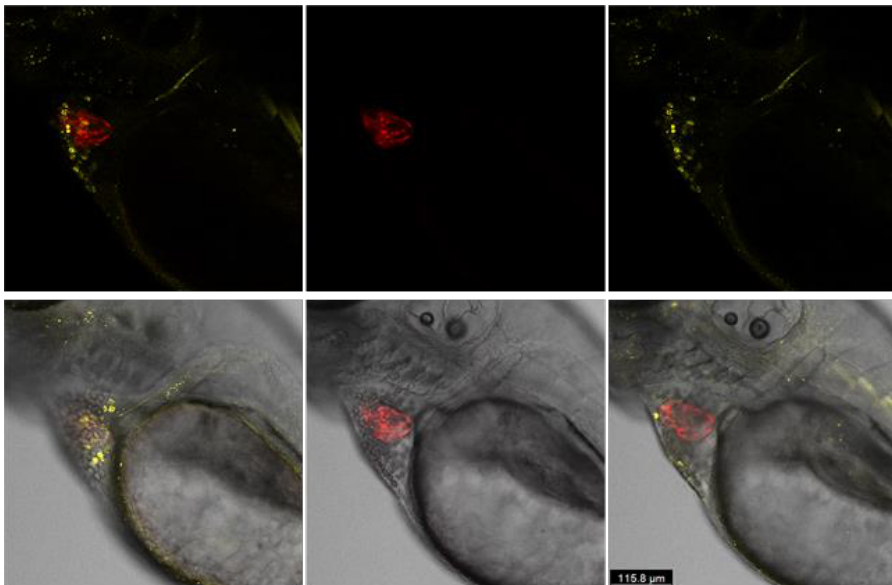
Figure 2. In vivo confocal imaging of the 72 hpf stage of the newly developed homozygous zebrafish larval strain of Tg(UAS:SEC-Hsa.ANXA5-YFP,myl7:RFP); Casper( roy −/− ,nacre −/− ) . RFP (red fluorescent protein) expression shows myl7 specific to the heart, while YFP (yellow fluorescent protein) expression shows annexin-5 of the tissue and muscle area, and Casper: transparent skin.